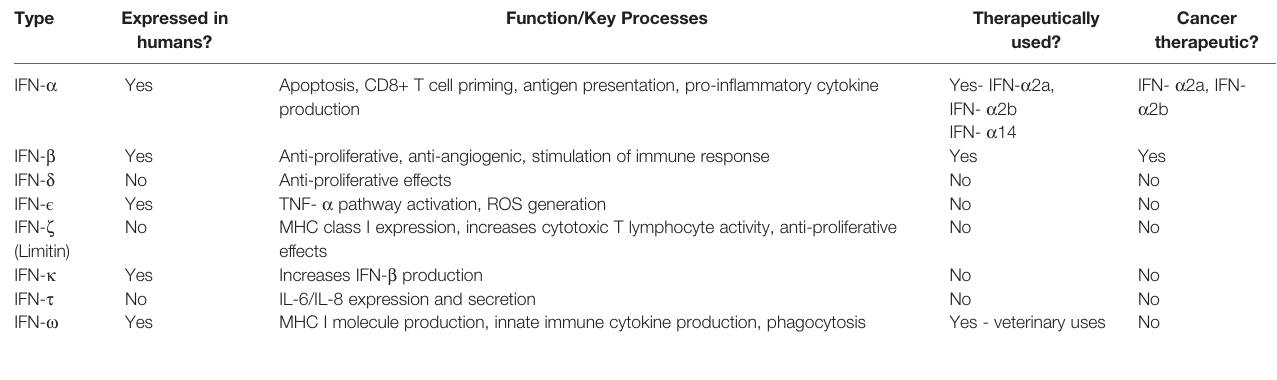
TABLE 1 | Summary of the Canonical Functions of Type I Interferons and Therapeutic Potential. Type Expressed in humans?